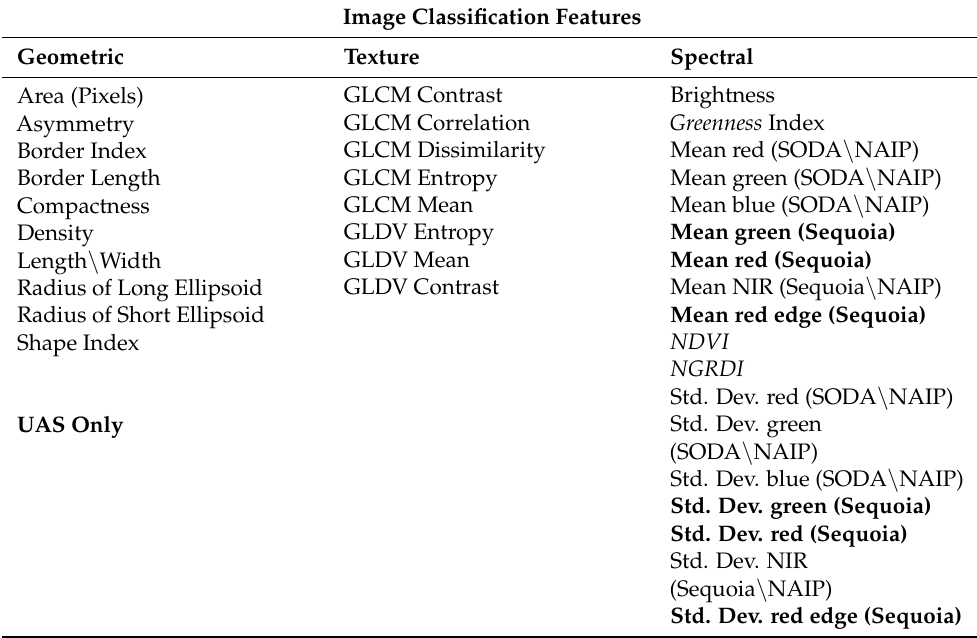
Table A2. Image object features created using eCognition for the purpose of forest health classification using (1) UAS and (2) NAIP segmented